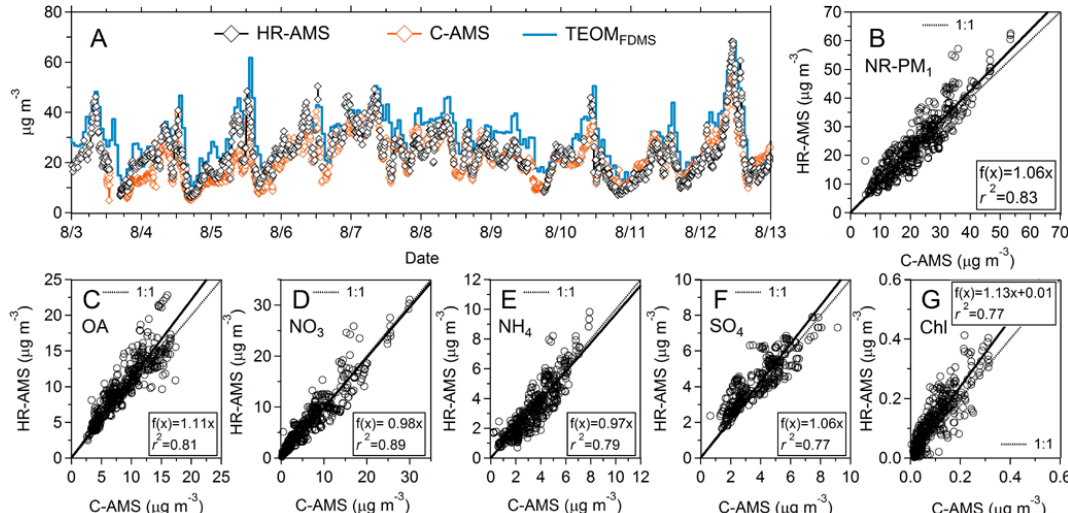
Fig. 3. Time series of NR-PM 1 concentrations measured by each ToF-AMS over the period 8/3–8/13–2005 are shown in panel A. TEOM FDMS concentrations are also provided for visual reference. Scatter plots of total and speciated NR-PM 1 are shown in panels B- G with the results of linear regression and correlation ( r 2 ) values also provided in each